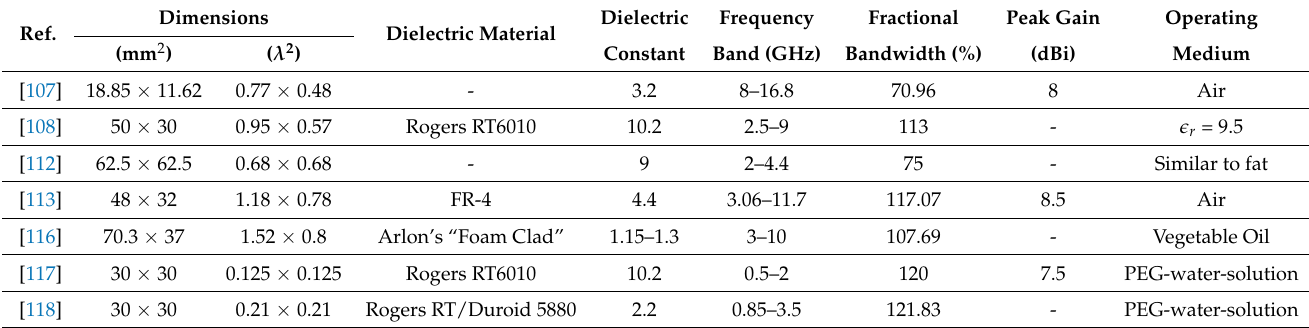
Table 5. Performance comparison among bowtie antennas designed for microwave imaging